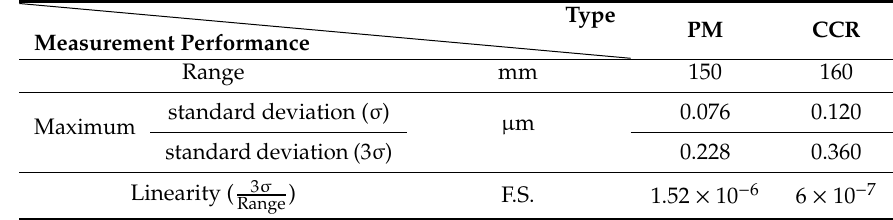
Table 2. The comparison result of the proposed measurement structure between the PM type and the CCR type.